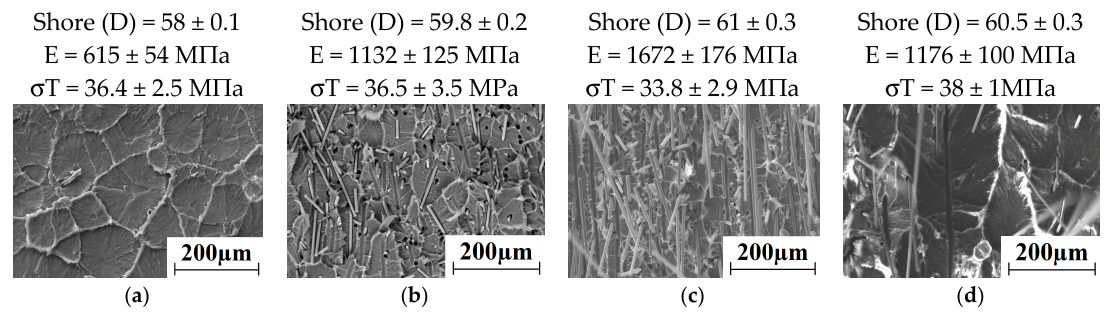
Figure 14. SEM-micrographs of the permolecular structure: ( a ) UHMWPE + 0.5% CNF; ( b ) UHMWPE + 10% CF; ( c ) UHMWPE + 10% LCF; ( d ) UHMWPE + 10% HDPE-g-SMA + 2% LCF + 0.5% CNF.